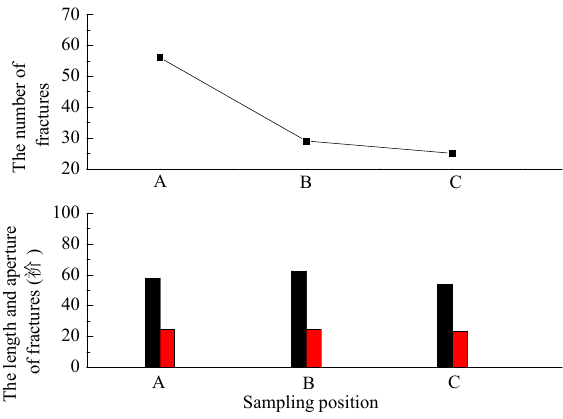
Figure 14. Variation characteristics of fracture parameters in oil shale.